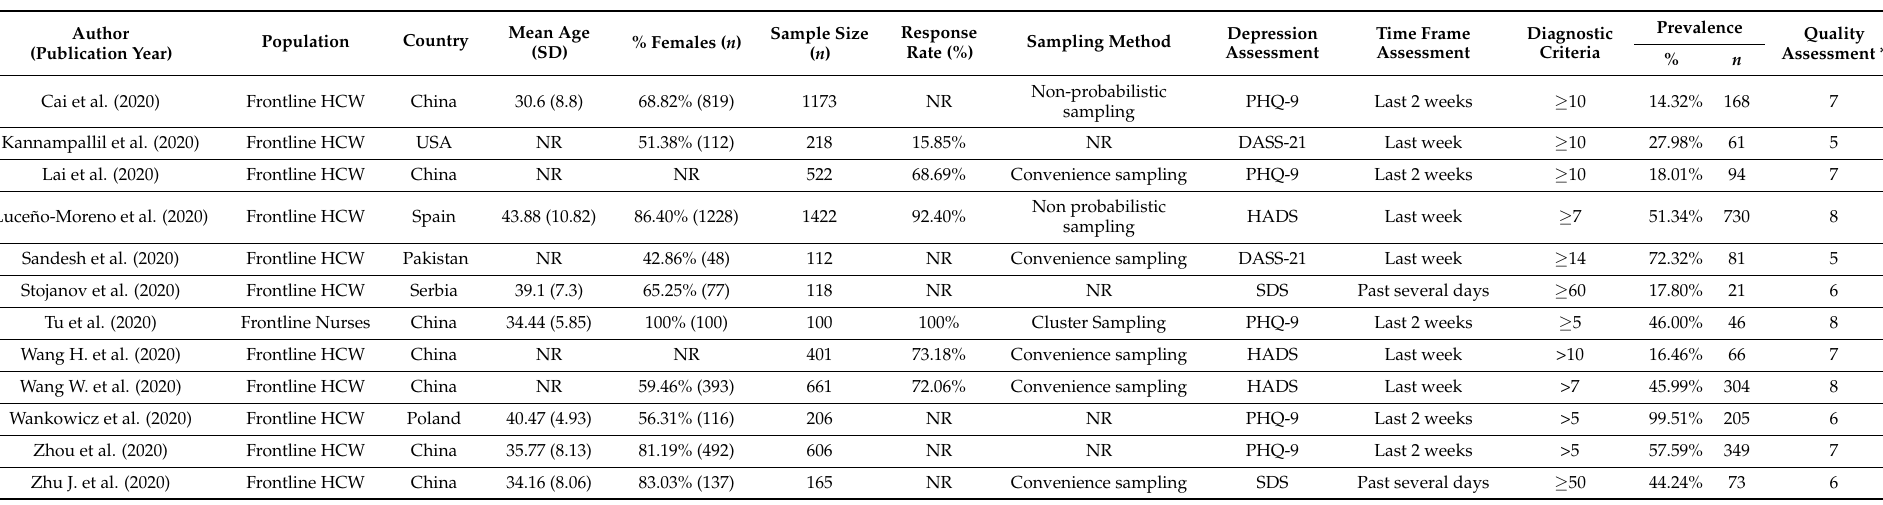
Table 4. Characteristics of the studies included in the meta-analysis based on samples of frontline healthcare